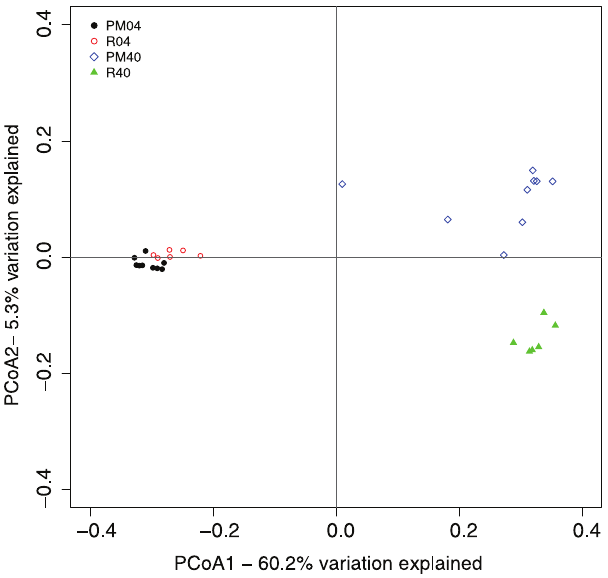
Figure 4. Principal Coordinates Analysis ordination using weighted Unifrac distances. The amount of variation explained for each axis is indicated in percentages. Samples are grouped color wise based on location (pockmark vs. reference sediments) and depth (4 cm vs. 40 cm) in the figure.